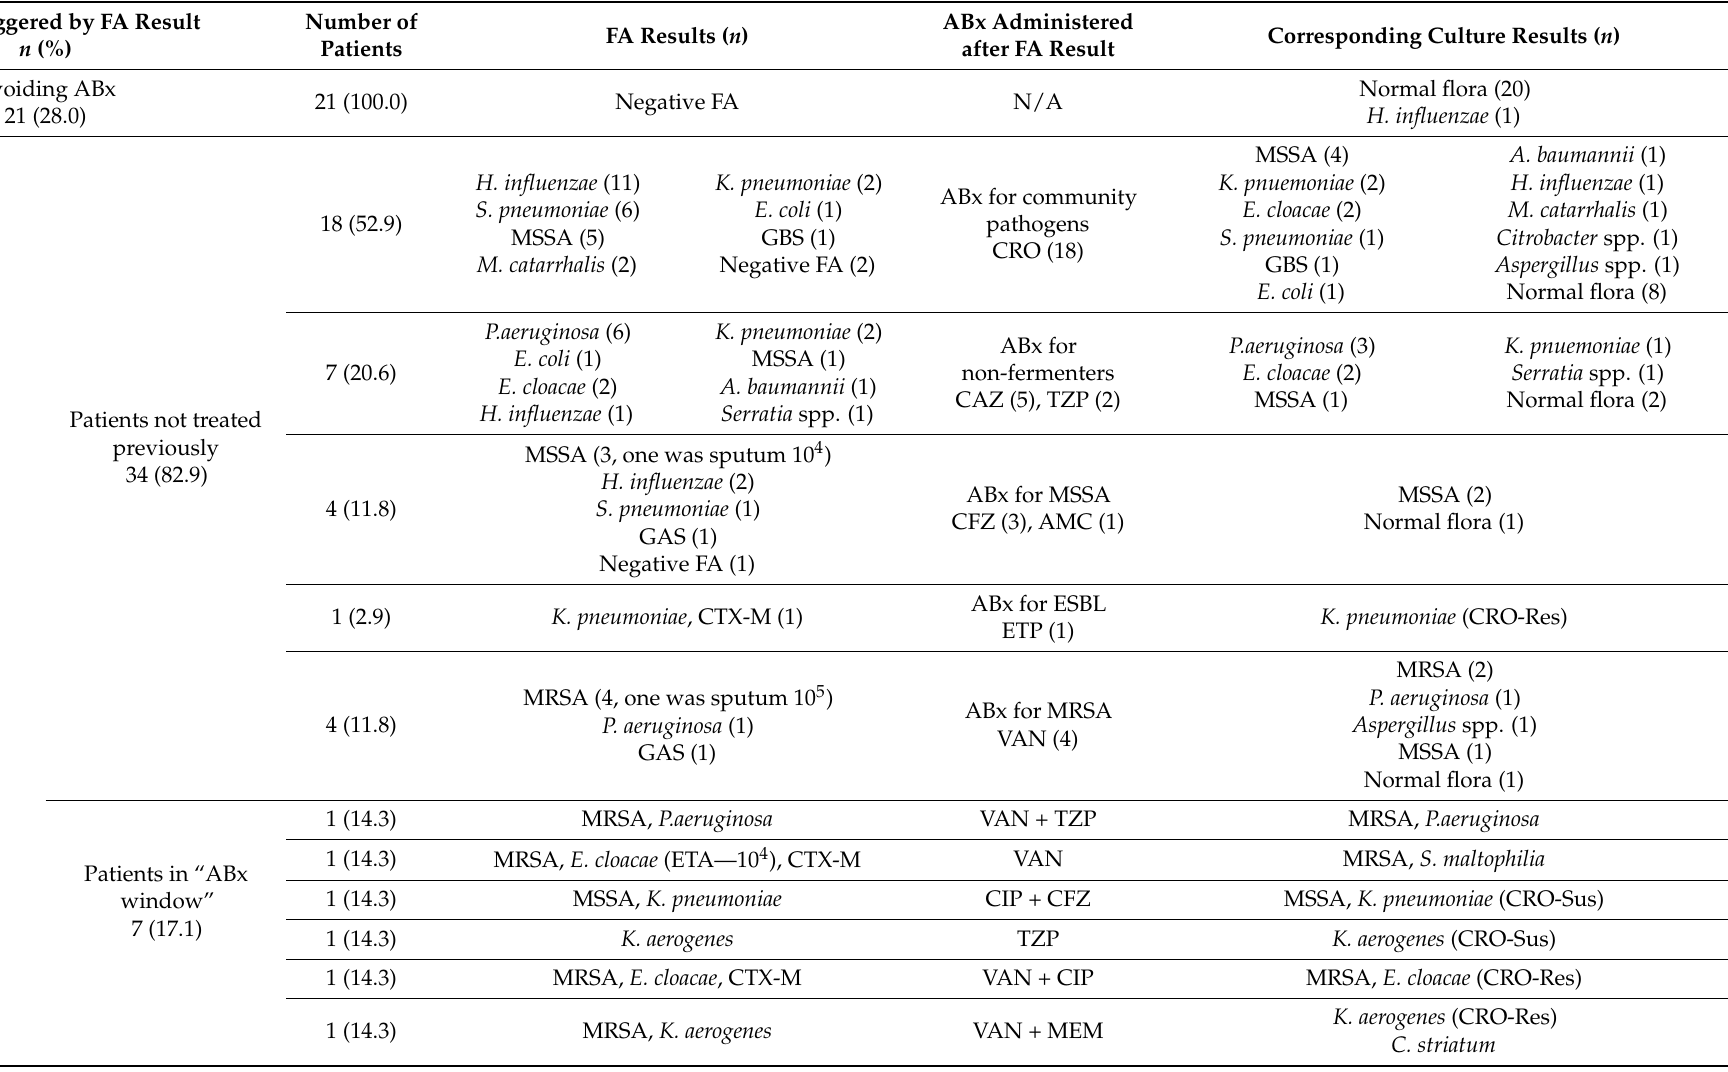
Table 5. Cases in which antimicrobials were avoided, started, or stopped as a result of FA